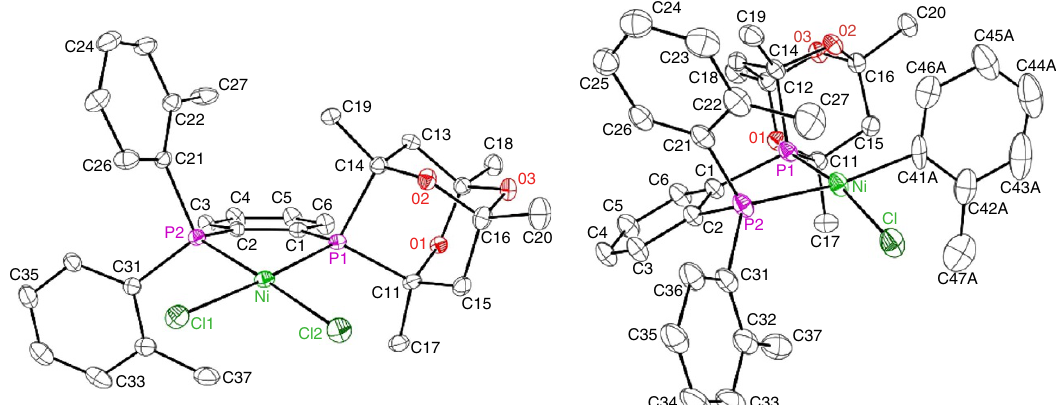
Figure 5 | Single-crystal X-ray structures of (L1)NiCl 2 and C1 depicted with hydrogen atoms omitted for clarity. Selected interatomic distances (Å) and angles ( (cid:2) ): for ( L1 )NiCl 2 Ni-P1 2.1903(12), Ni-P2 2.1691(13), Ni-Cl1 2.2195(13), Ni-Cl2 2.1865(13), P1-Ni-P2 86.74(5), P1-Ni-Cl2 94.03(5), P2-Ni-Cl1 88.88(5), Cl1-Ni-Cl2 90.37(5); for C1 : Ni-P1 2.1766(8), Ni-P2 2.2263(8), Ni-Cl 2.1916(8), Ni-C(aryl) 1.971(3), P1-Ni-P2 86.52(3), P1-Ni-C(aryl) 95.79(10), P2-Ni-C1 92.72(3),